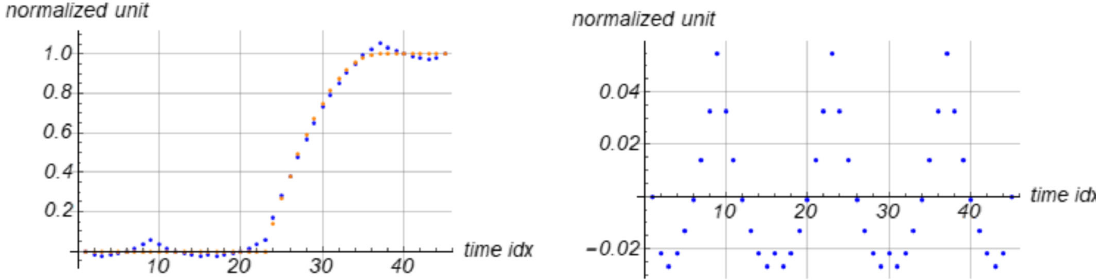
FIG. 31. Left: Compensation voltage (blue) and beam induced voltage (orange). Right: Compensation